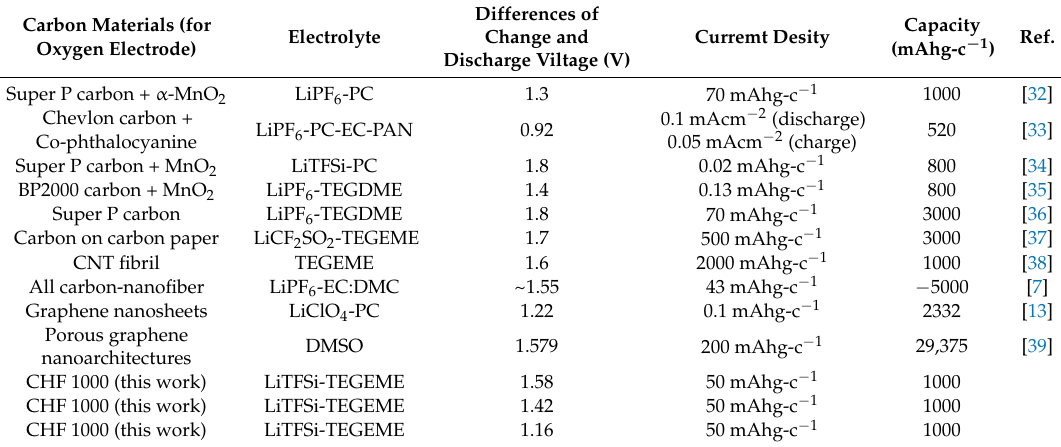
Table 1. Some typical achievements for lithium oxygen cells in cathode materials, electrolytes, difference of charge and discharge voltage, and current density.